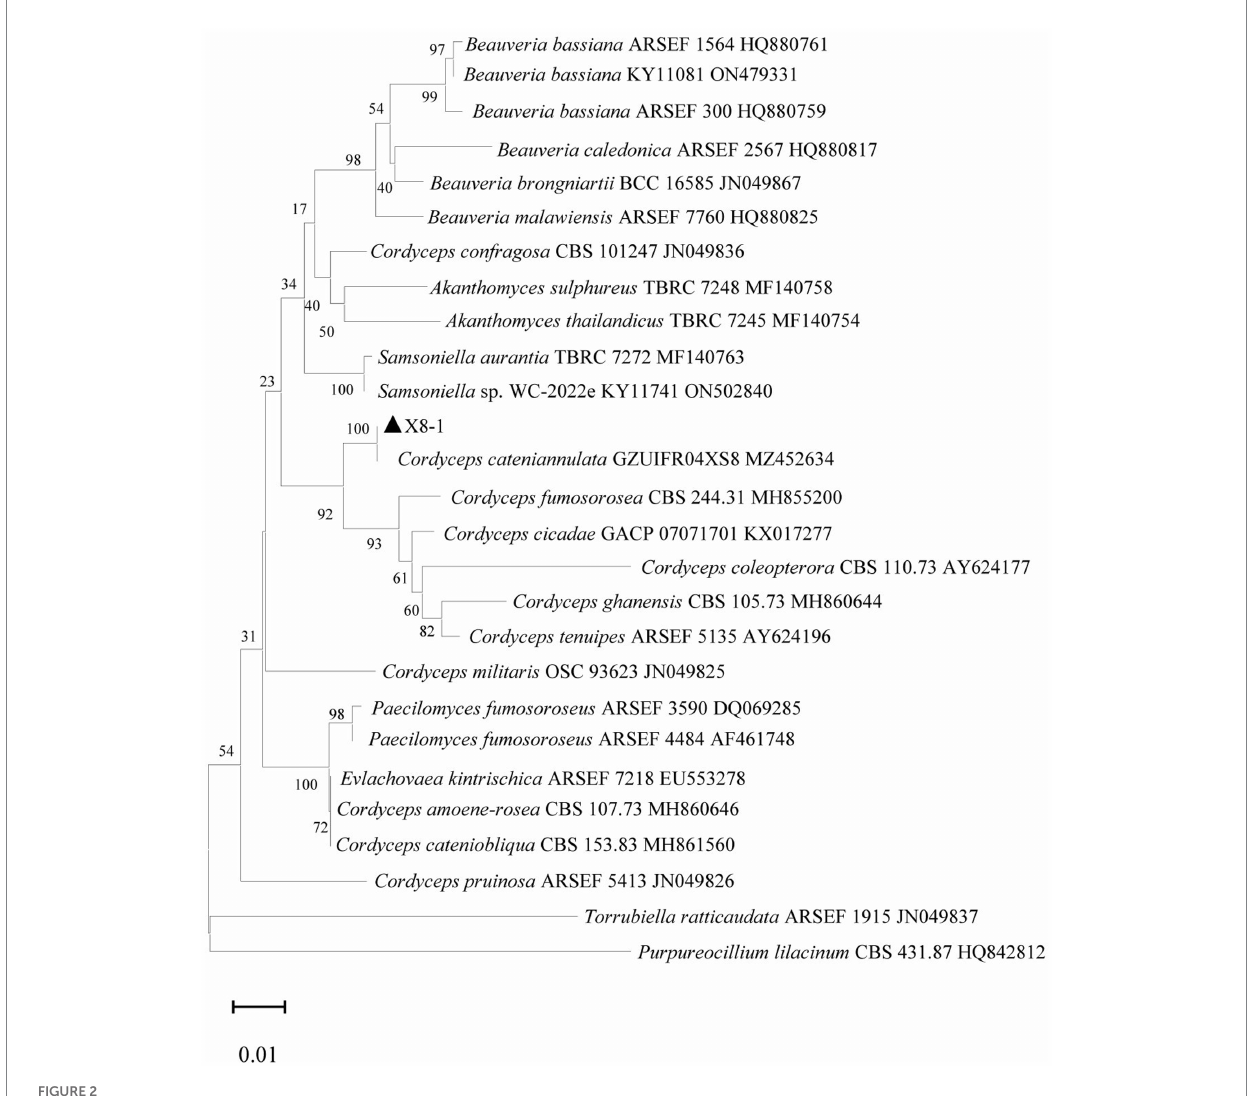
FIGURE 2 Phylogenetic tree generated with rDNA-ITS sequences of strain X and other related